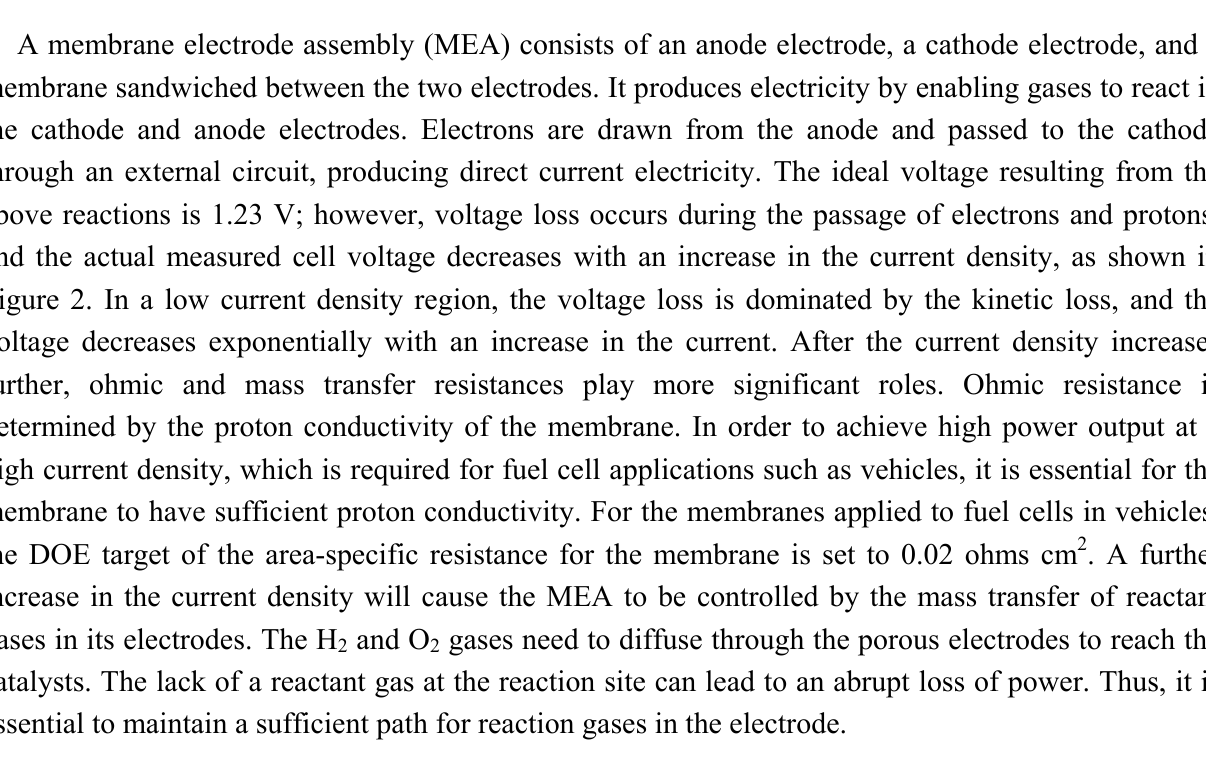
Figure 2. Current voltage